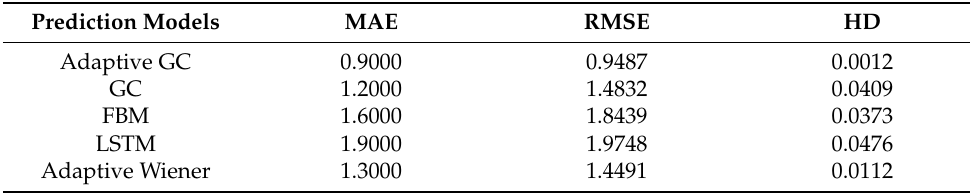
Table 6. Prediction Accuracy of the Five Models. Prediction